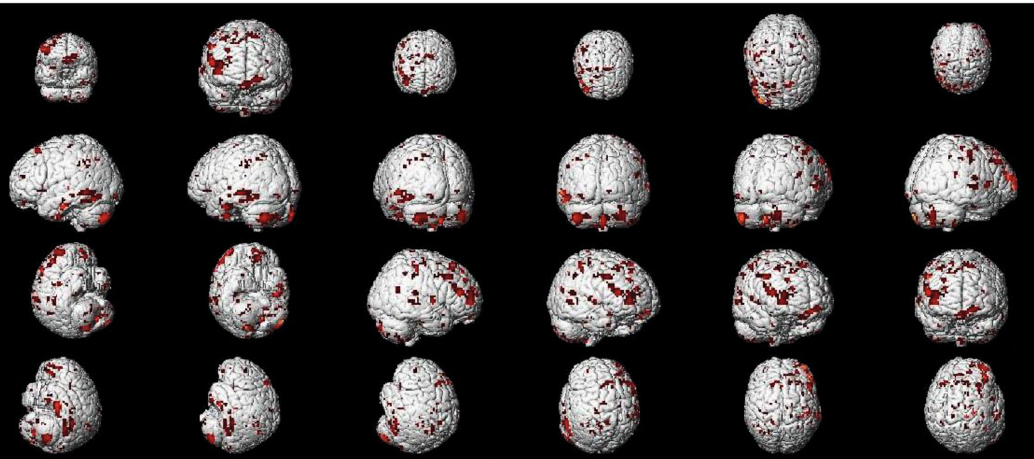
Figure 12: Regions showing signi fi cantly di ff erent EC with the rACC in placebo response compared with nocebo response (IG).